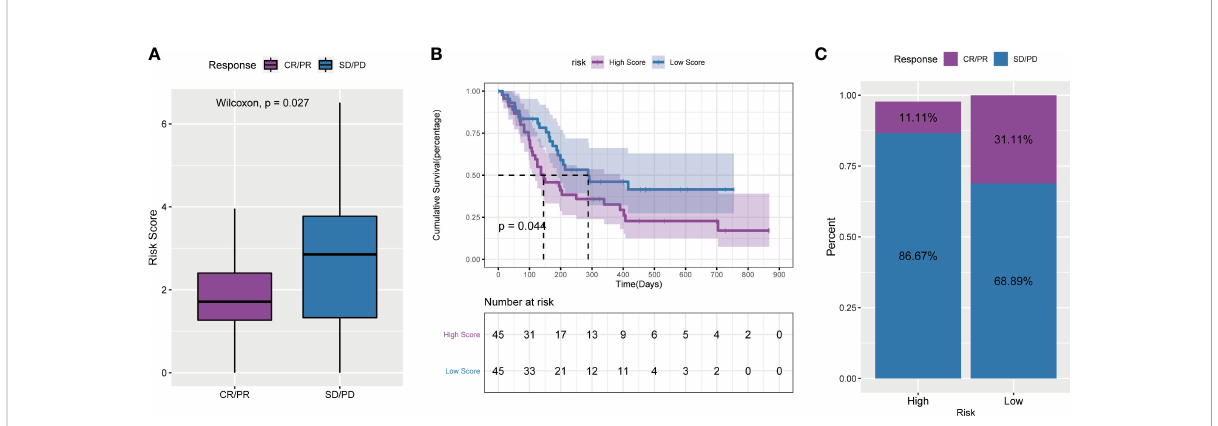
FIGURE 12 Tumor risk score and prediction of immunotherapy response. (A) Comparison of risk scores between responders and non-responders in the ICB immunotherapy cohort; (B) Survival curves of high and low risk score groups in the cohort receiving ICB immunotherapy; (C) ICB scores in the high and low risk score groups Proportion of patients who responded to